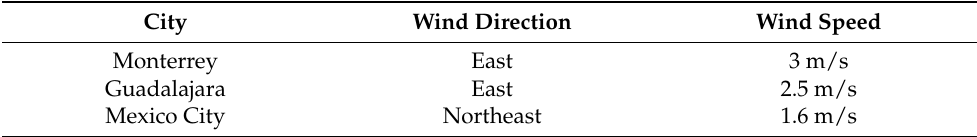
Table 4. Meteorological condition of studied areas.